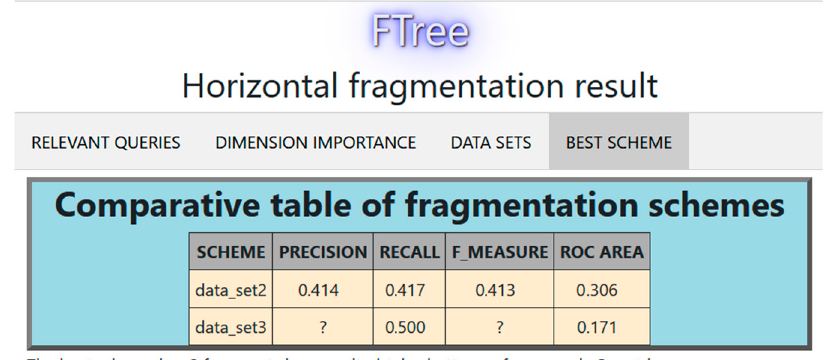
Figure 9. Partition tree for the second experiment with the tourist DW.